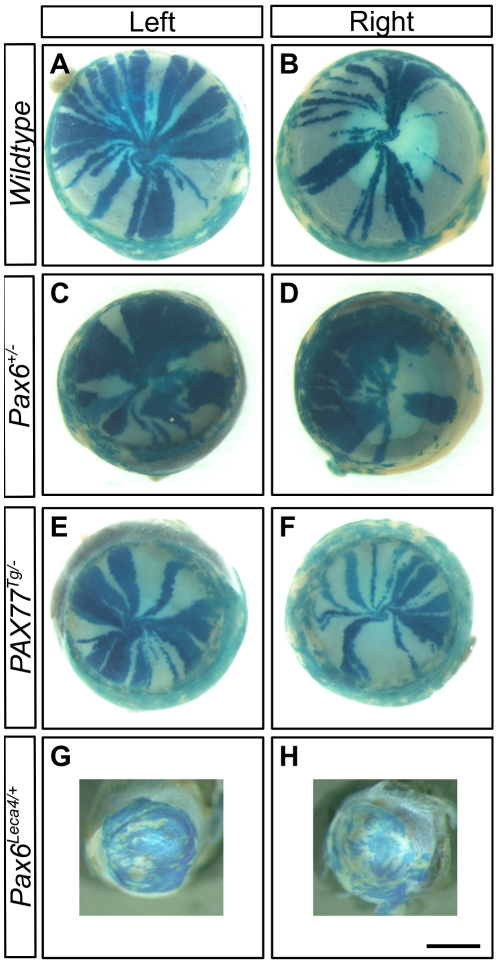
Mosaic patterns in the corneal epithelium.Representative images of β-gal staining in the corneal epithelia of X-inactivation mosaic eyes showing variation in mosaic patterns among the four different genotypes: (A,B) WT, XLacZTg/−; (C,D) Pax6+/−, XLacZTg/−; (E,F) PAX77Tg/−, XLacZTg/− and (G,H) Pax6Leca4/+, XLacZTg/−. Scale bar = 1 mm.